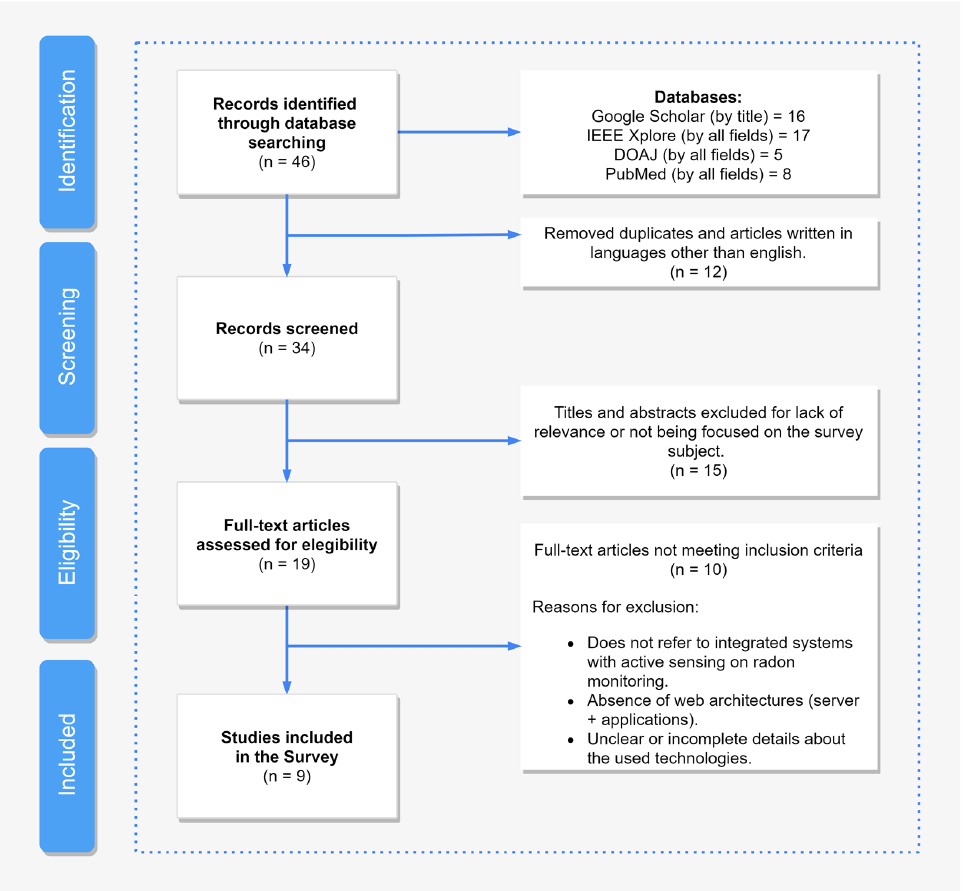
Figure 1. Flow diagram of the adopted methodology.